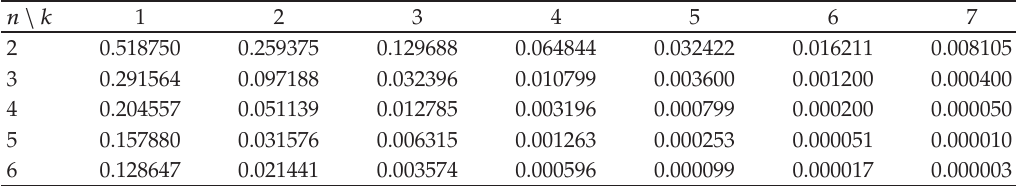
Table 1: Error bound of tensor product n -ary interpolating volumetric models: here n presents the arity of subdivision volumetric model and k presents the subdivision level.